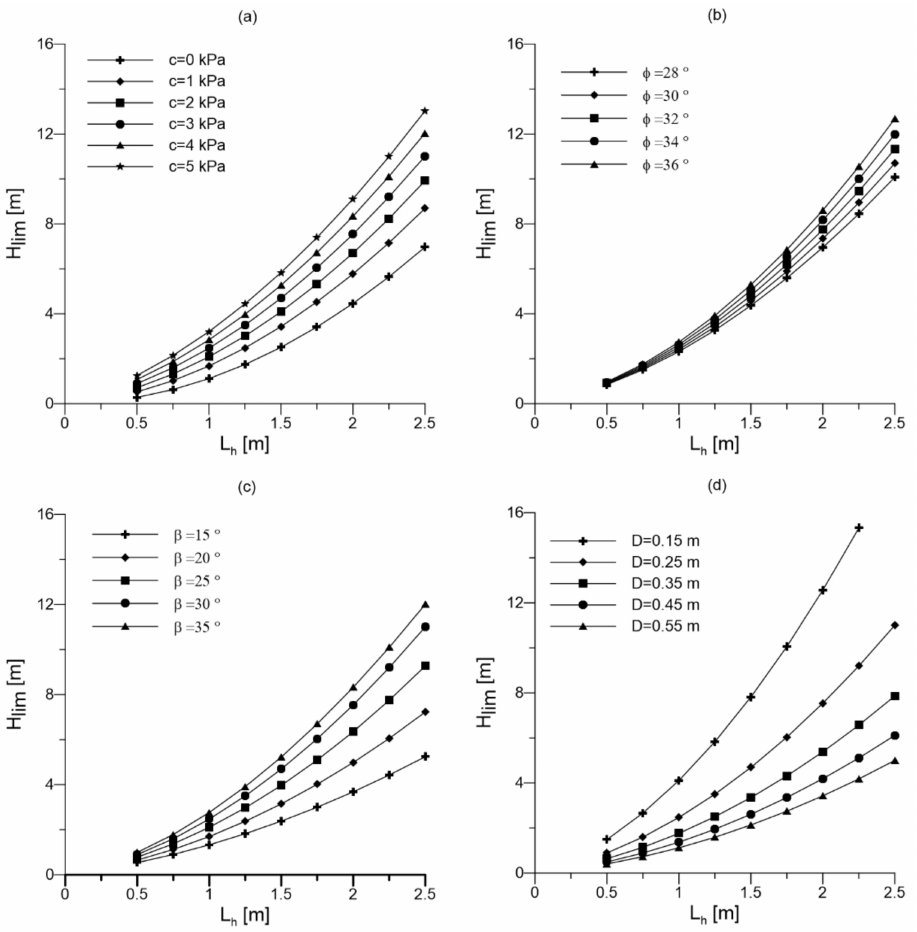
Figure 5. Limit hydraulic level as function of L h (if not otherwise specified D = 0.25 m, γ = 18 kN/m 3 , c = 3 kPa, φ = 31 ◦ , β = 30 ◦ ): ( a ) effect of cohesion, ( b ) effect of friction angle, ( c ) effect of slope inclination, and ( d ) effect of the cavity